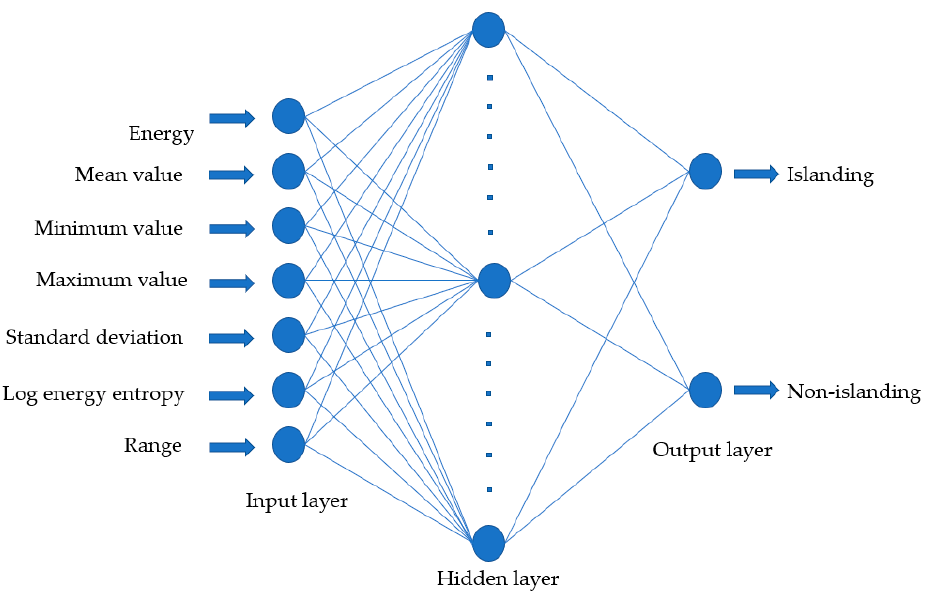
Figure 7. Structure of ANN with seven input features.